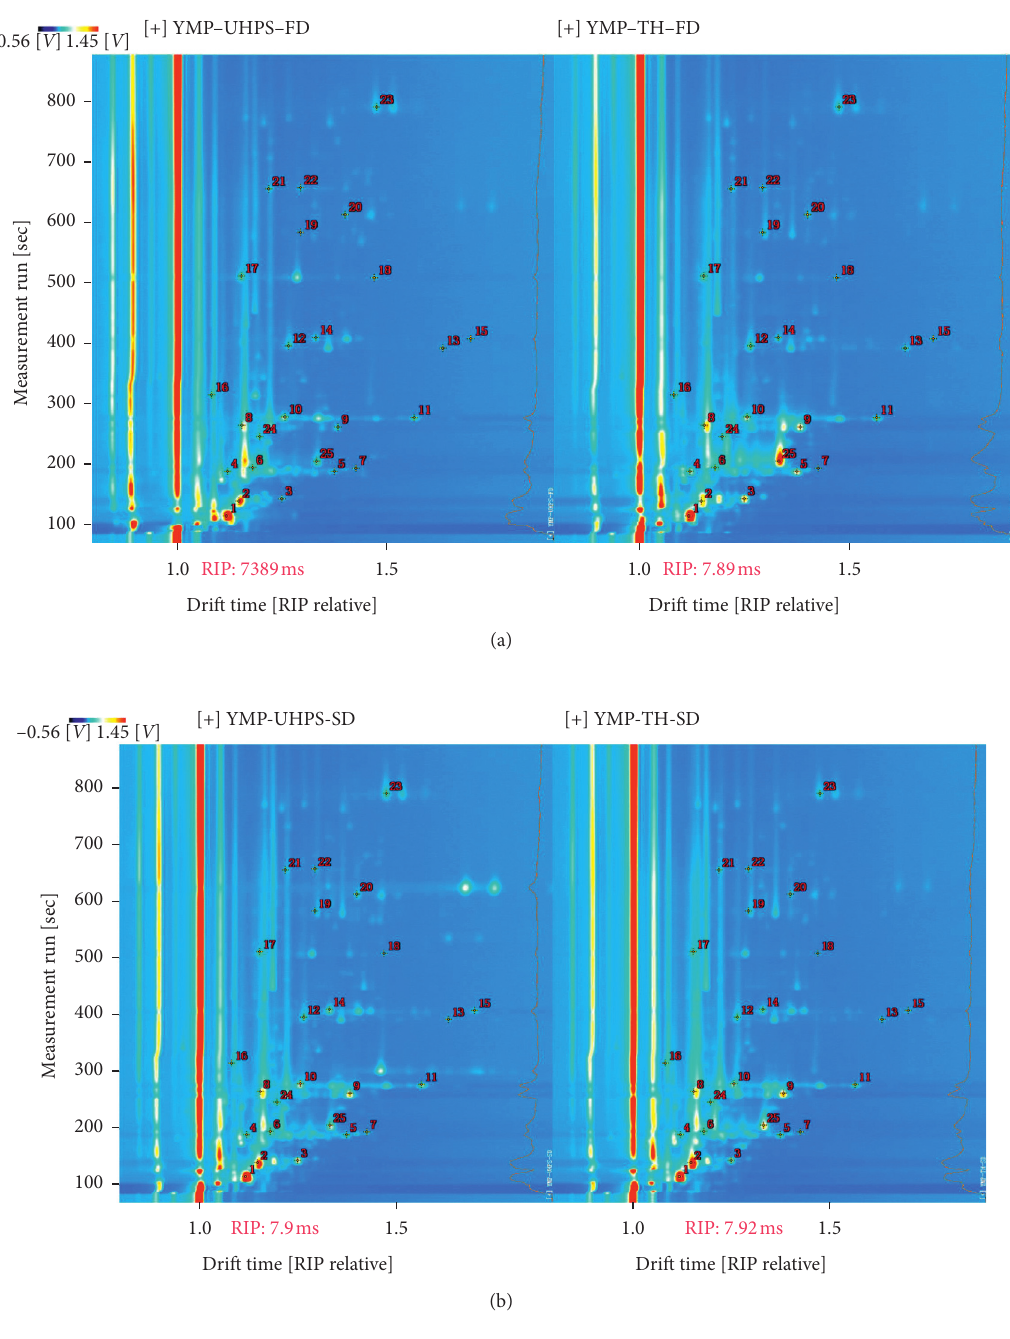
Figure 1: HS-GC-IMS spectra of YMP after different sterilization methods. The numbers are qualitative volatile components. Table 1: Qualitative results of YMP with different sterilization